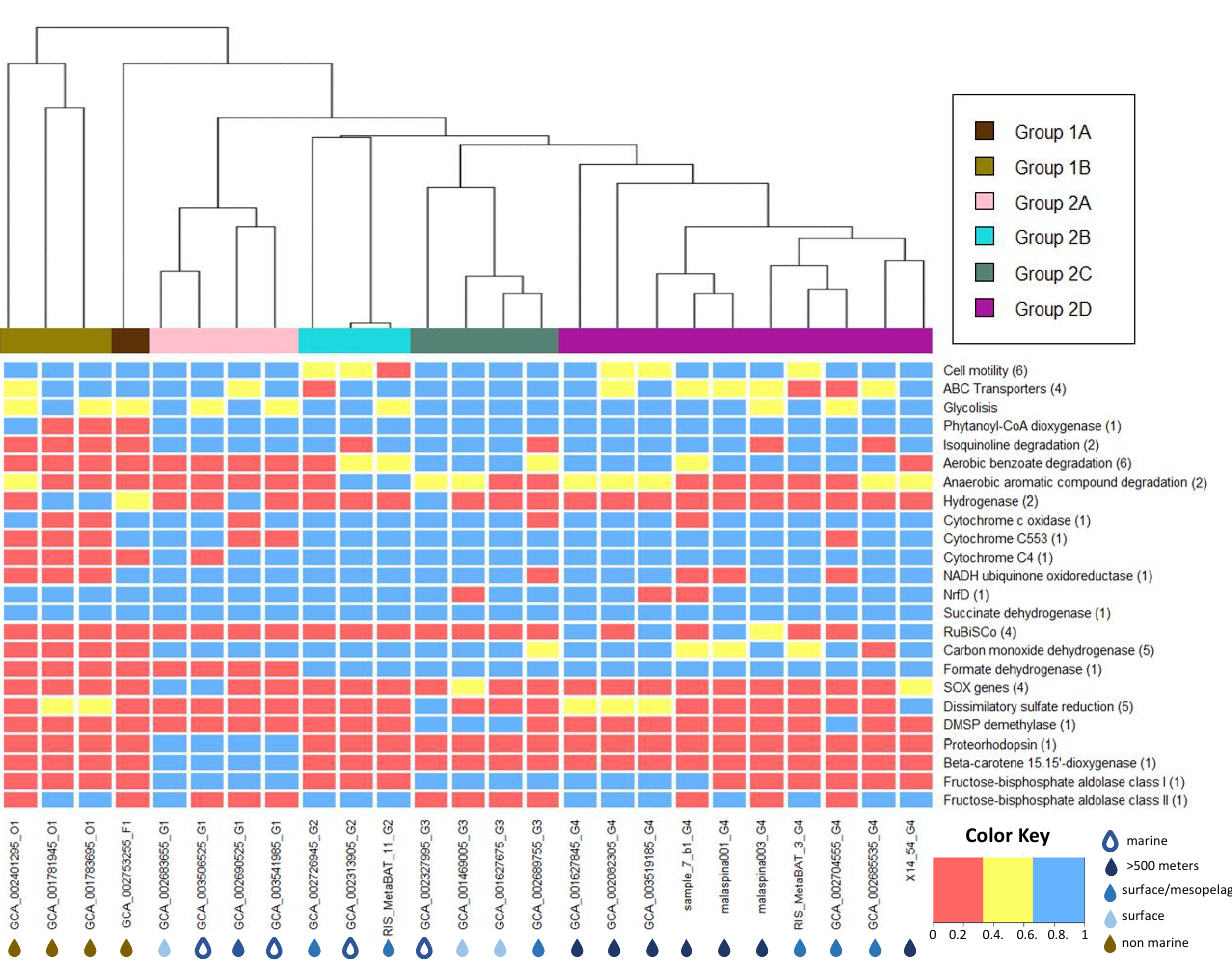
Figure 3. Presence/absence of selected genes or traits. The number in parenthesis indicates how many genes were used to define the respective trait (for more information regarding which genes were used, see Supplementary Table S2). Red color indicated the gene/trait is not present (contains <33% of the genes encoding the respective enzyme/pathway), yellow indicated partially present (33–66%) and blue present (>66%). On the bottom, genomes are additionally annotated with their respective environment.